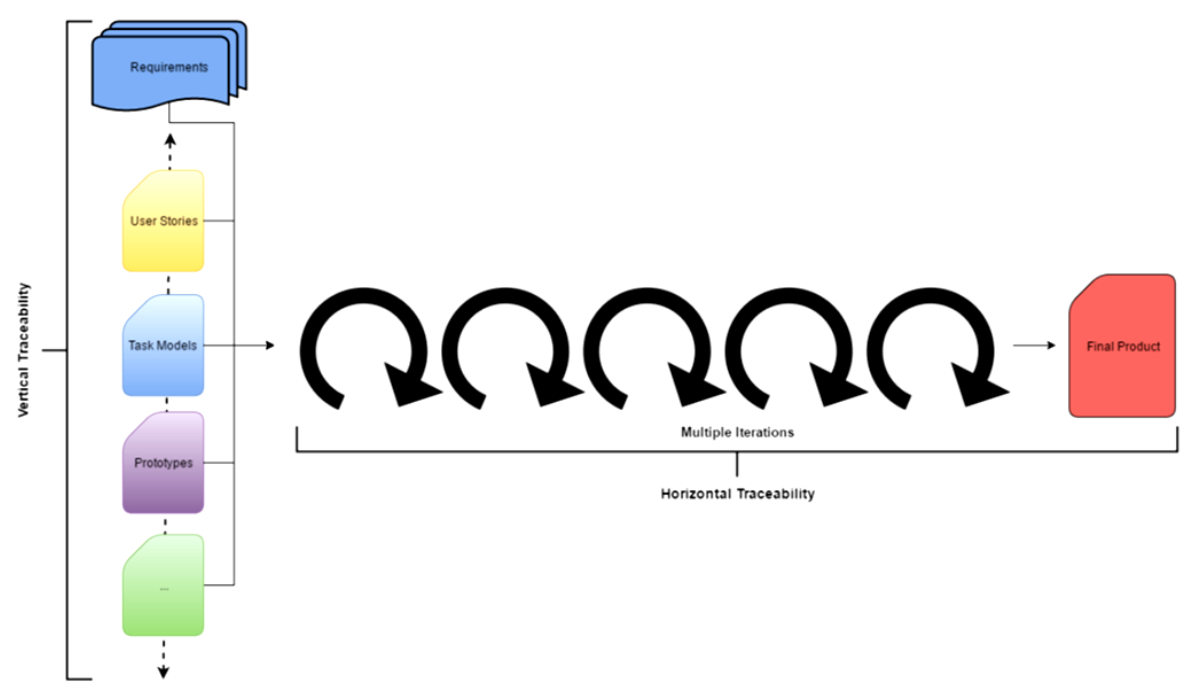
Figure 1. The cycle of permanent evolution of artifacts in iterative